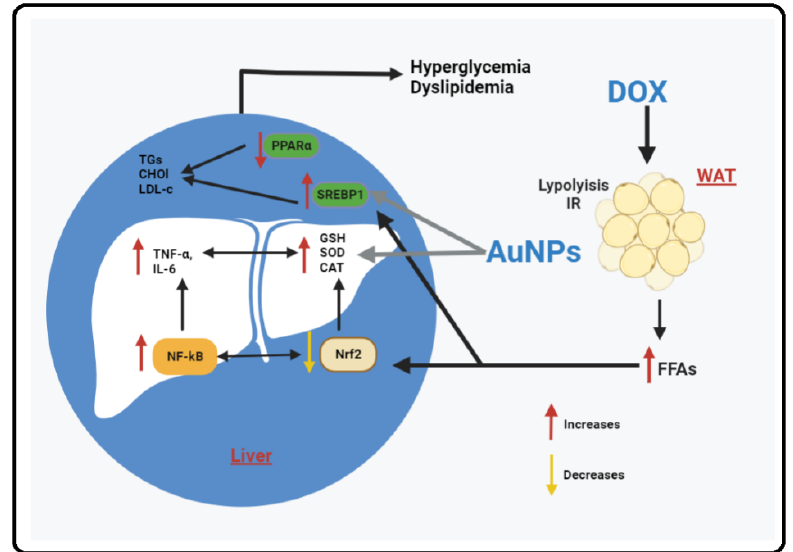
Figure 6. A graphical abstract demonstrating the synergistic hepatic toxic effect of doxorubicin (DOX) and small-sized gold nanoparticles (AuNPs) in rats. In the figure, DOX triggers insulin resistance (IR) and lipolysis and the white adipose tissue (WAT), which leads to an increase in the influx of free fatty acid (FFAs) to the livers and induces oxidative stress and inflammation by the generation of reactive oxygen species (ROS) and scavenging glutathione (GSH), superoxide dismutase (SOD), and catalase (CAT), suppression of Nrf2, activation of NF- κ B p65, and increasing levels of inflammatory mediators such as tumor necrosis factor- α (TNF- α ) and interleukin-6 (IL-6). In addition, DOX (possibly through increasing hepatic FFAs) can directly stimulate SREBP1 and inhibit PPRA α . On the other hand, AuNPs affect liver health and lipogenesis by acting on oxidative stress and inflammatory markers (similar to the effect of DOX) as well as inhibiting SREBP1. ALT, AST, and γ -GTT are the most used markers for assessing liver function and are